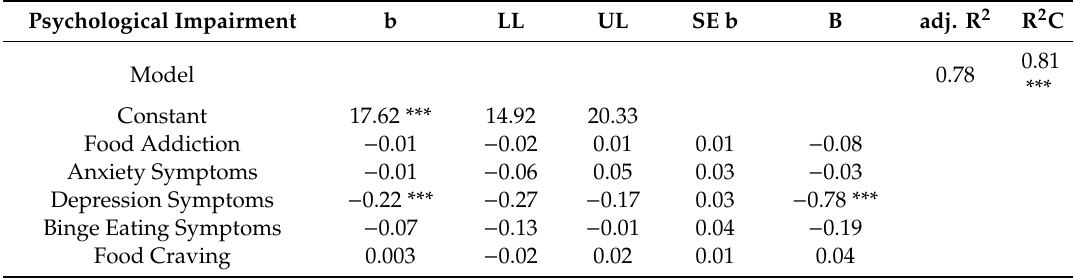
Table3. MultipleregressionresultspredictingpsychologicalimpairmentsmeasuredusingtheWHOQOL-bref. Psychological Impairment